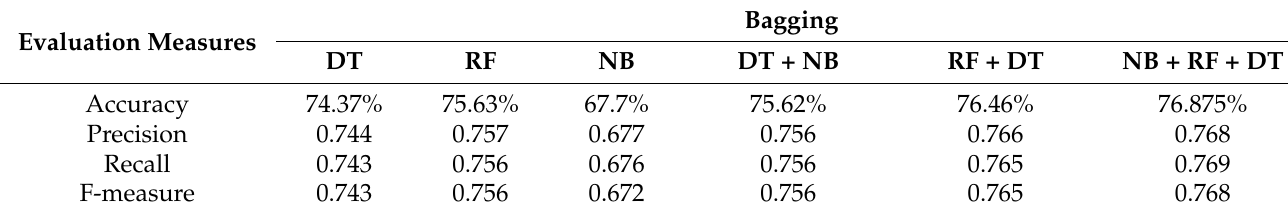
Table 4. Classification results with bagging.